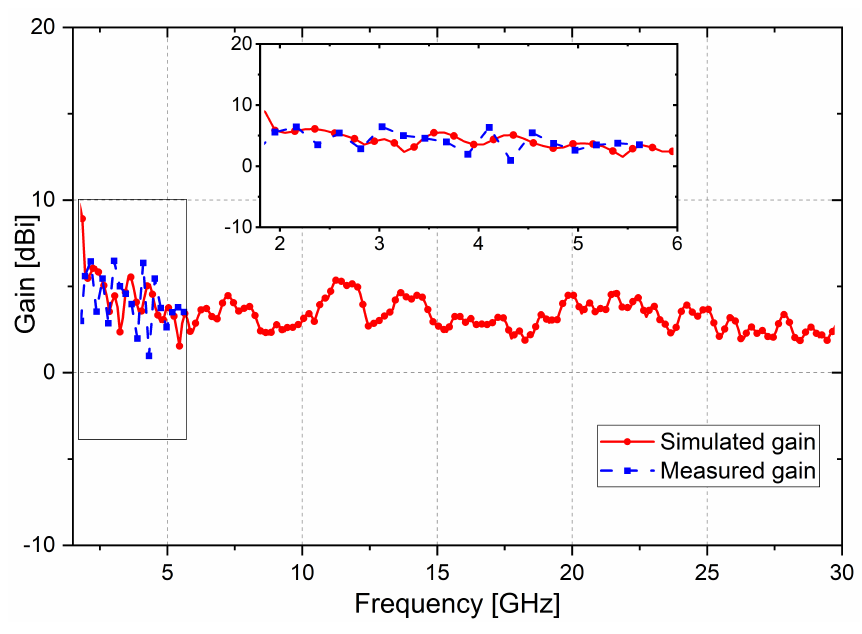
Figure 12. Measured and simulated gain of the proposed antenna. Table 1. Comparison of the SWB antenna structures fabricated on FR-4 substrates in terms of various